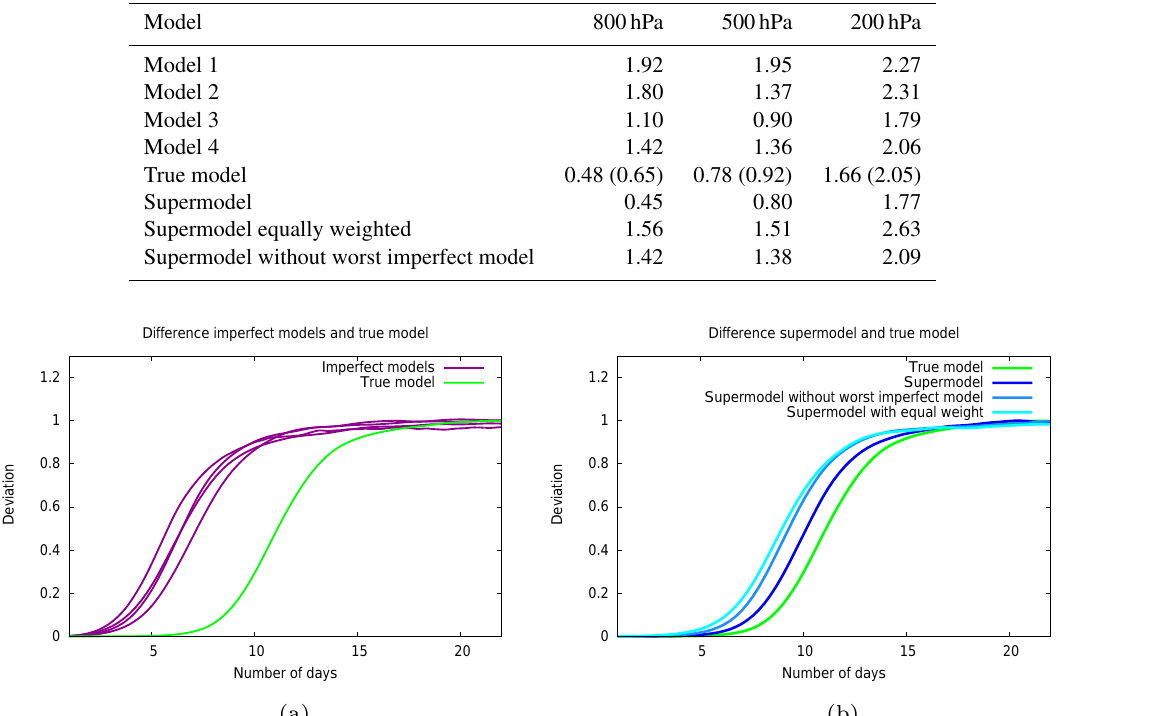
Figure 6. Forecast quality of imperfect QG models (purple), the QG supermodel (dark blue), the QG supermodel generated without the worst imperfect model in forecast quality (medium blue) and the QG supermodel generated with equal weights (light blue) compared to the forecast quality of the true QG model